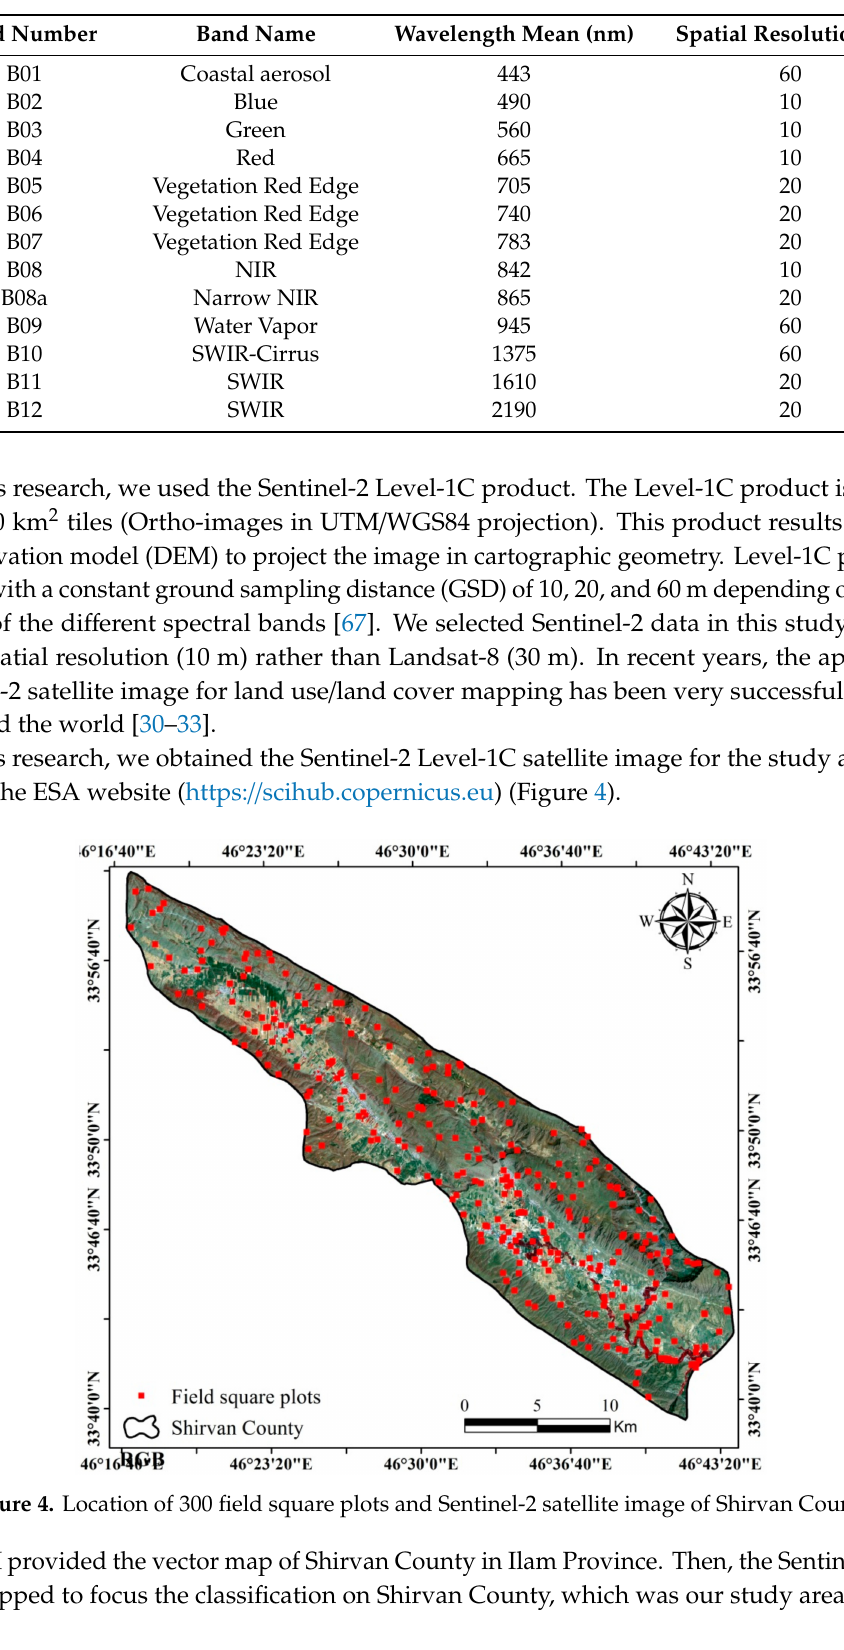
Table 1. The spectral bands of Sentinel-2 data.